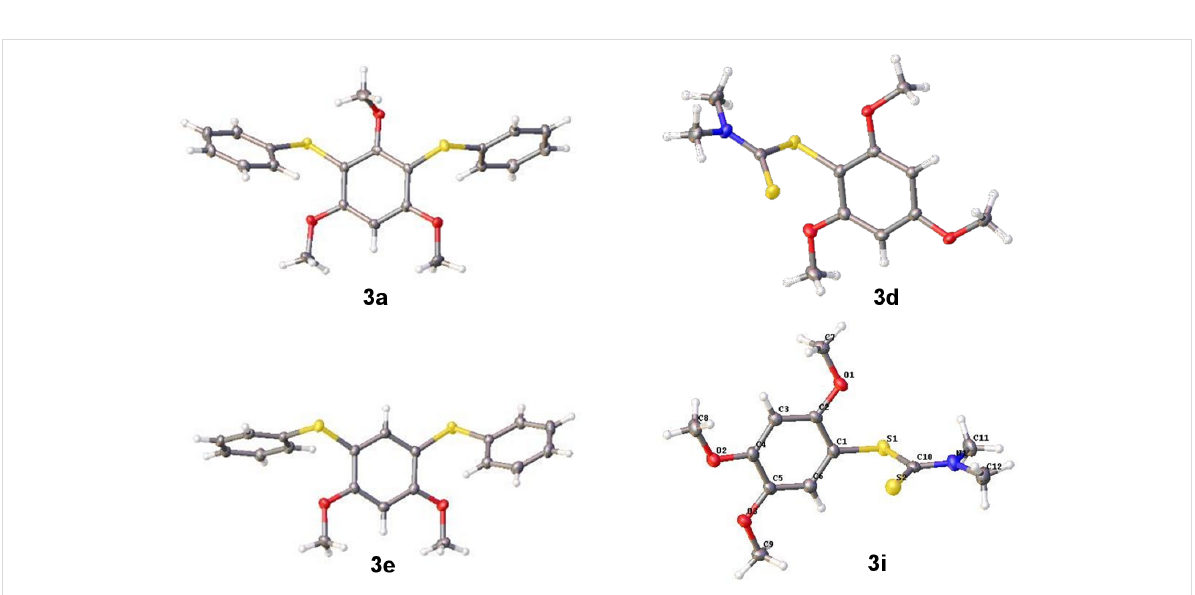
Figure 2: Crystal structures of compounds 3a , 3d , 3e and 3i